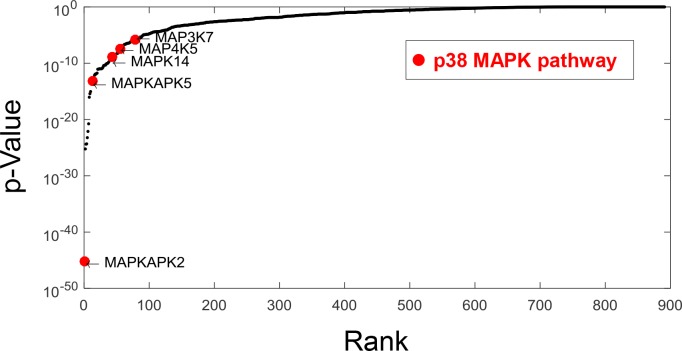
Ranked p-values from the enrichment analysis of compounds that increase cell size variability (by Fisher’s exact test).Components from the p38 pathway (highlighted) were highly enriched. Specifically, MK2/MAPKAPK2, a direct downstream substrate of p38 is the top-ranking genes that associate with increased cell size variability.